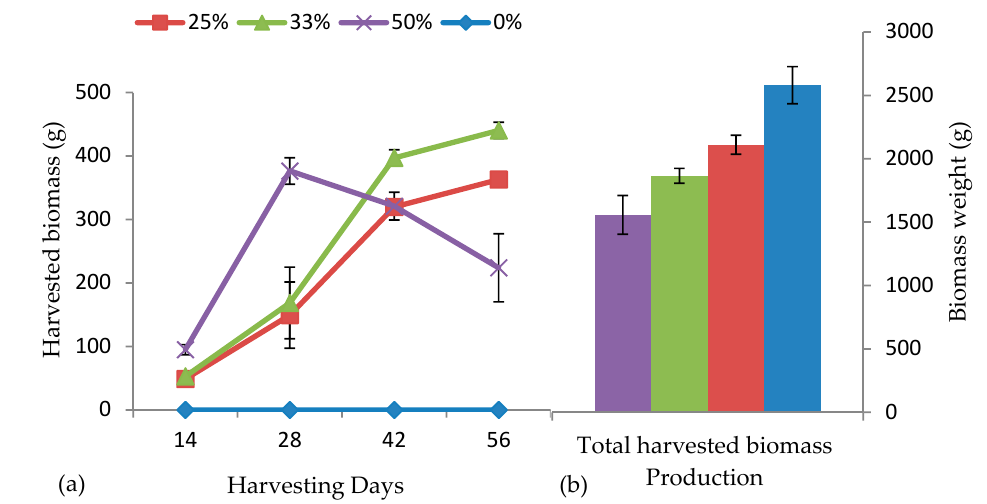
Figure 5. Harvested biomass of Nasturtium o ffi cinale in aquaponic systems under di ff erent harvesting regimes. ( a ) Amount of harvested plants on the 14th–56th days of the trial; ( b ) Total harvested biomass production in each treatment (data are the means of three replicates (n = 3), and error bars indicate the standard